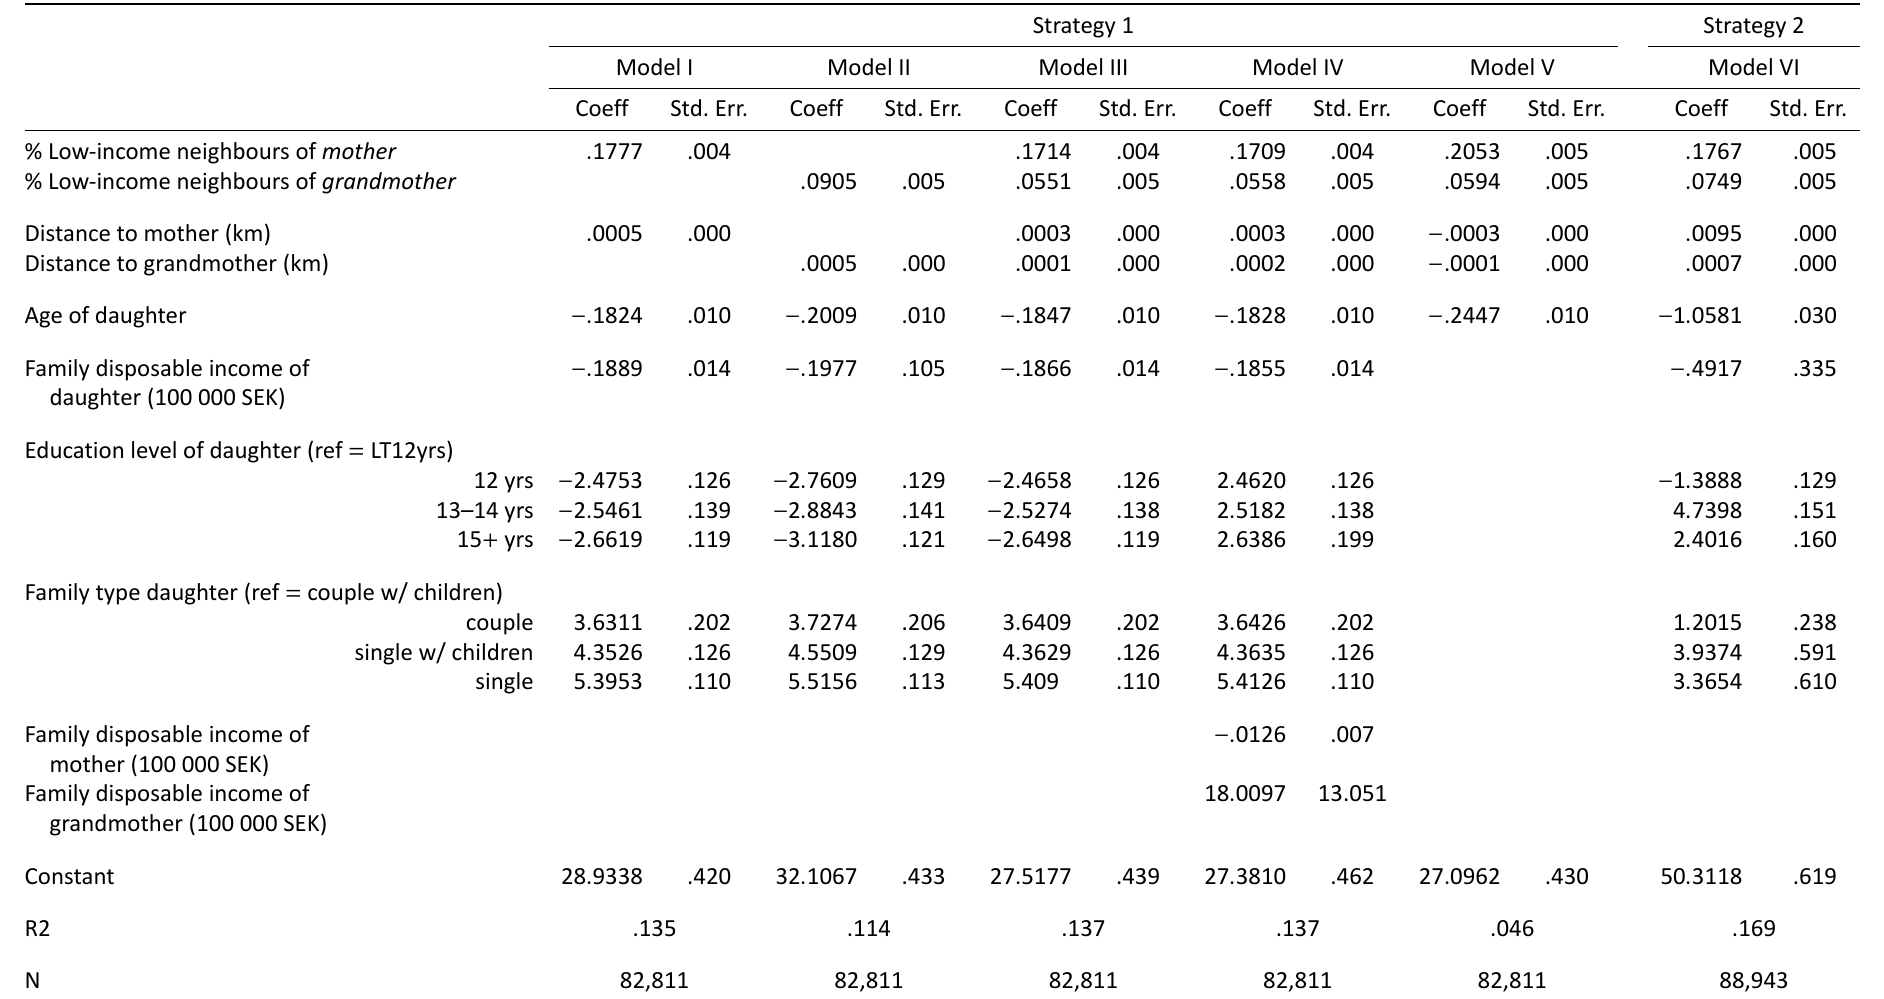
Table 3. Linear regression model using strategy